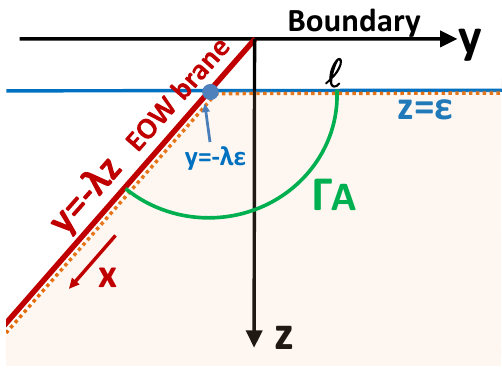
Figure 1 . A sketch of AdS/BCFT